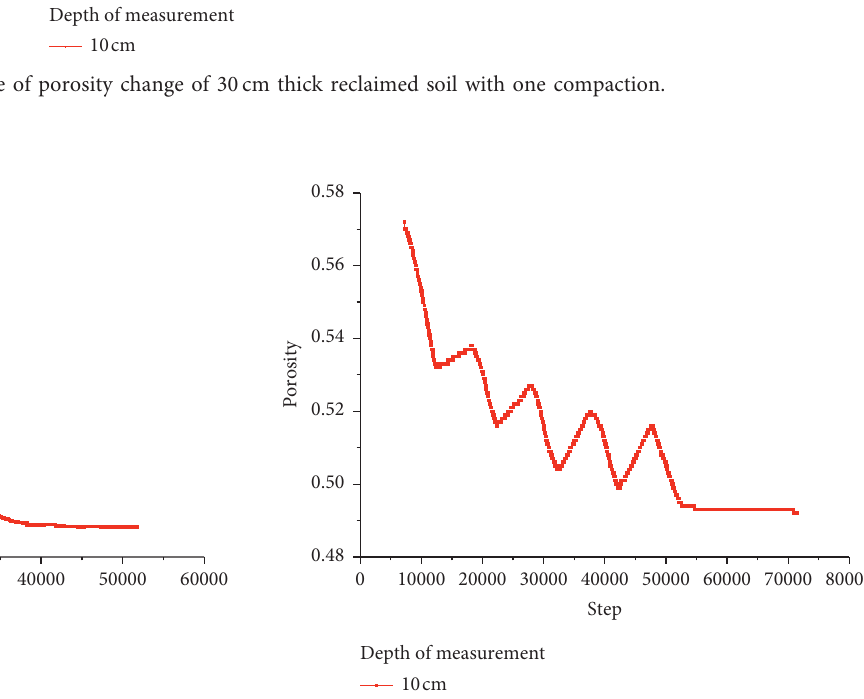
Figure 14: Curve of porosity change of 30 cm thick reclaimed soil with five